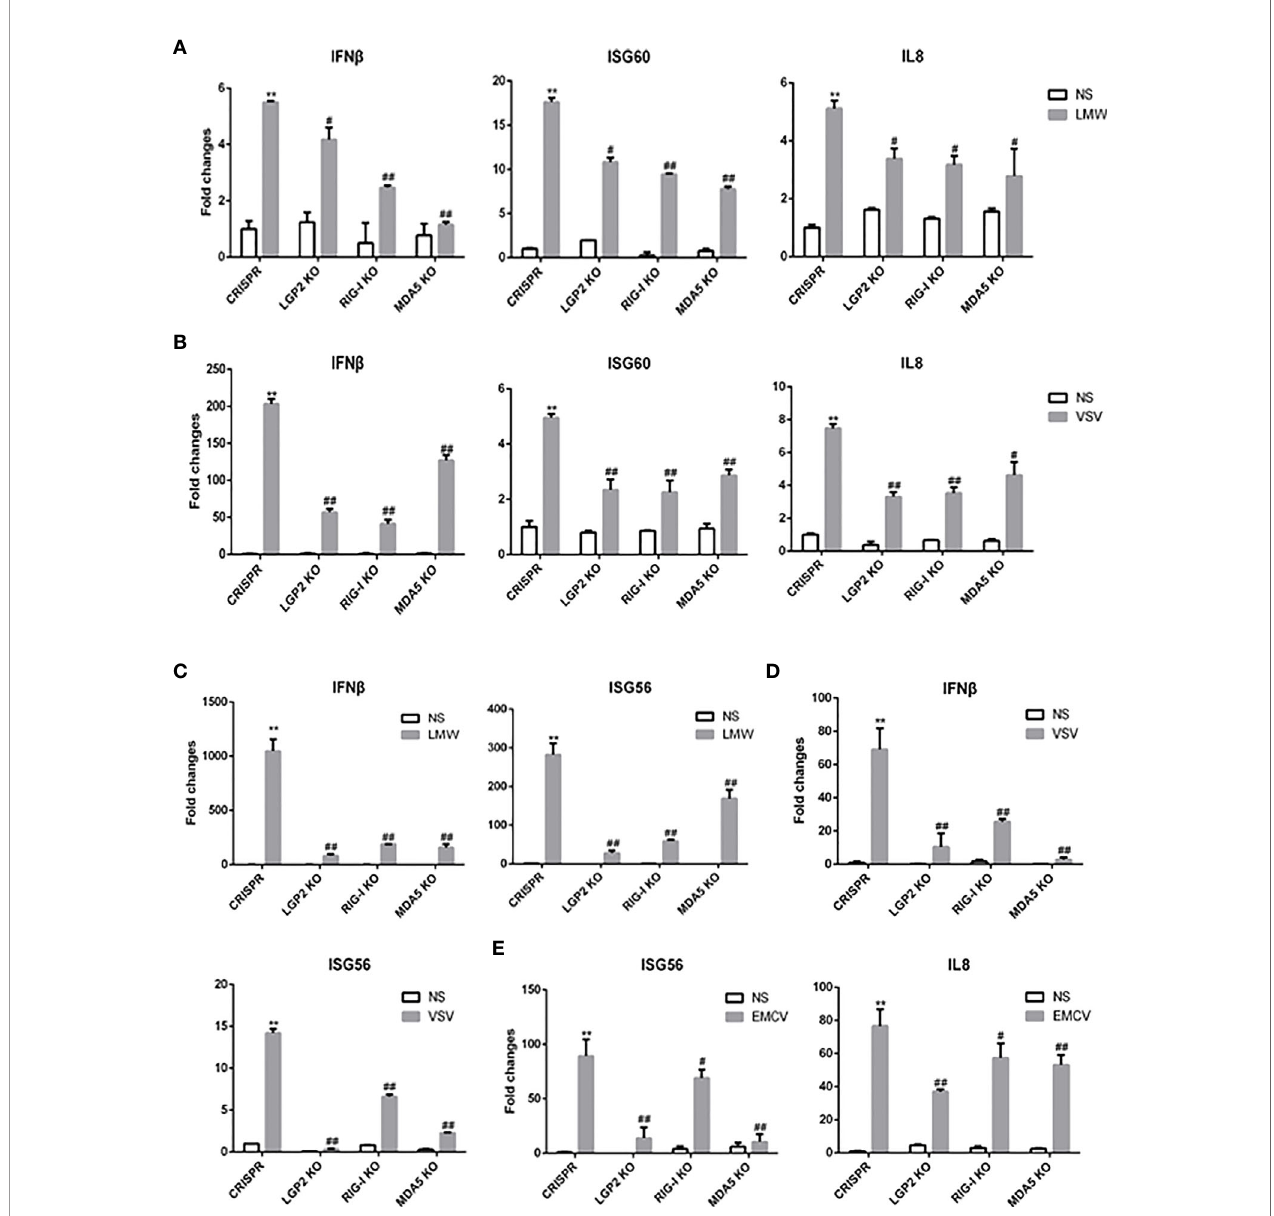
FIGURE 4 | Expressions of downstream genes in CRISPR KO stable cell lines upon stimulations. (A) The LGP2, RIG-I and MDA5 stable KO PAMs plus CRISPR control PAMs grown in 24-well plates (3×10 5 cells/well) were transfected with LMW poly I:C (1 m g/ml). Eight hours post transfection, the cells were analyzed by RT-qPCR for downstream gene expressions. (B) The LGP2, RIG-I, MDA5 stable KO and control PAMs were infected with VSV at MOI of 0.01 for 8h and analyzed as in (A) . (C) The LGP2, RIG-I and MDA5 KO PK15 cells plus CRISPR control PK15 cells grown in 24-well plates (3×10 5 cells/well) were transfected and analyzed as in (A) . (D, E) The LGP2, RIG-I, MDA5 stable KO PK15 cells were infected with VSV (D) or EMCV (E) at MOI of 0.01 and analyzed as in (A) . ** p < 0.01 vs CRISPR NS controls. # p < 0.05, ## p < 0.01 vs CRISPR stimulated